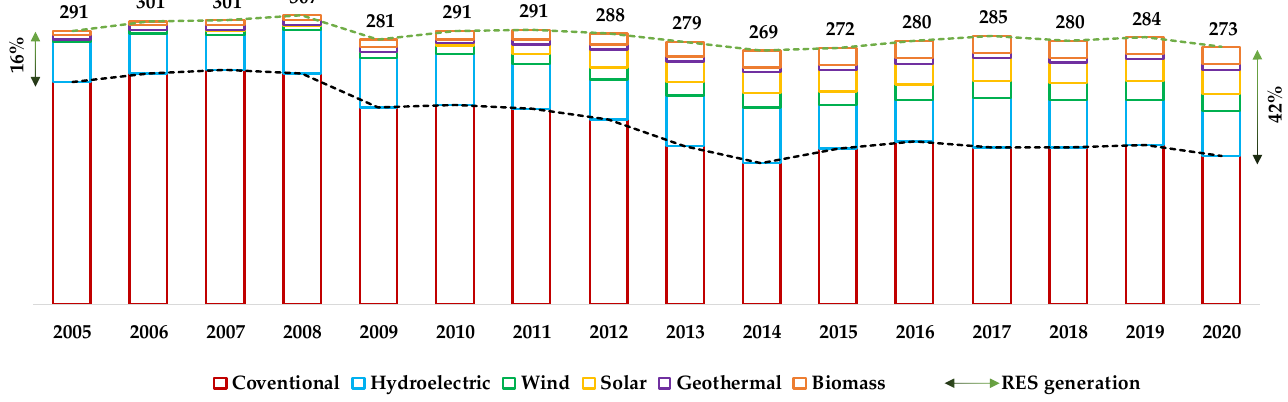
Figure 1. National net electricity generation by source.